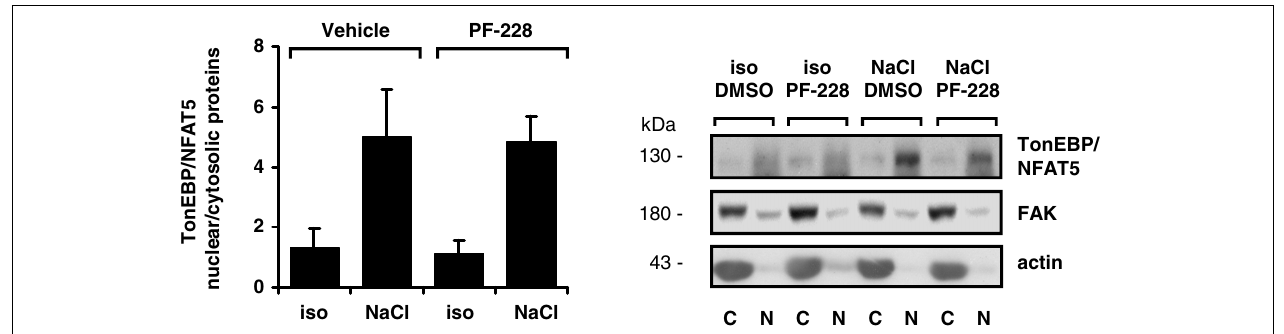
presence or absence of 10 μ M PF-228 or only vehicle ethanol. Thereafter, nuclear( N )andcytosolic( C )proteinfractionswereanalyzedforTonEBP/NFAT5 abundance.Means ± s.e.m.for n = 4;RepresentativeWesternblotsareshown.